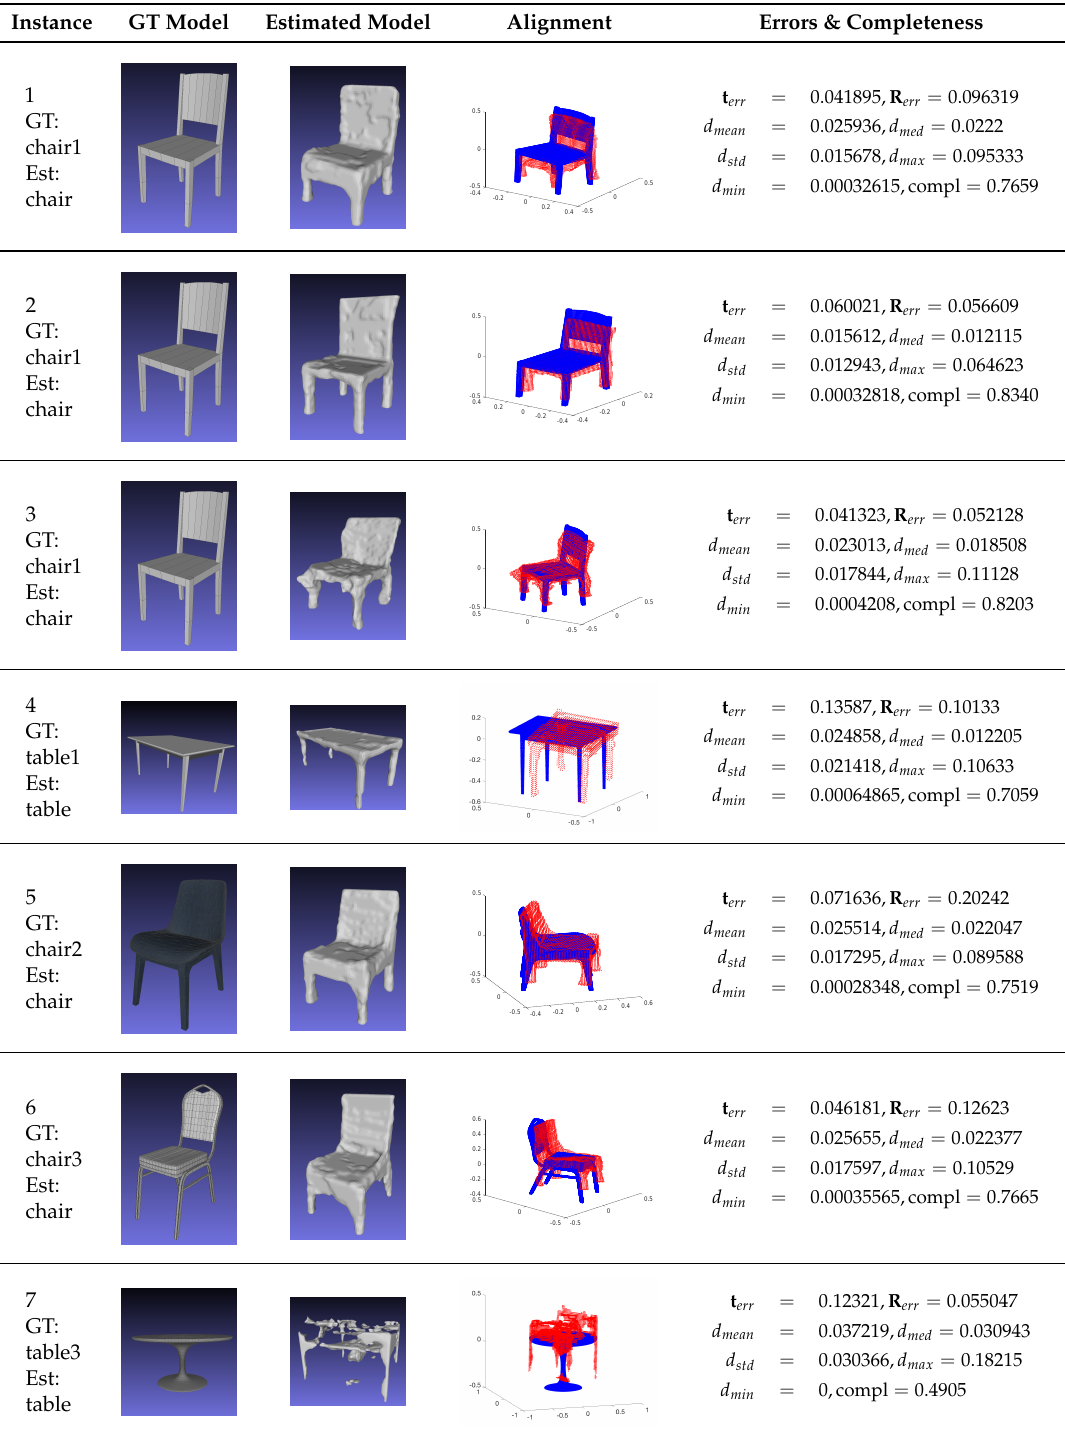
Table 5. Analysis of the objects semantically reconstructed on dataset